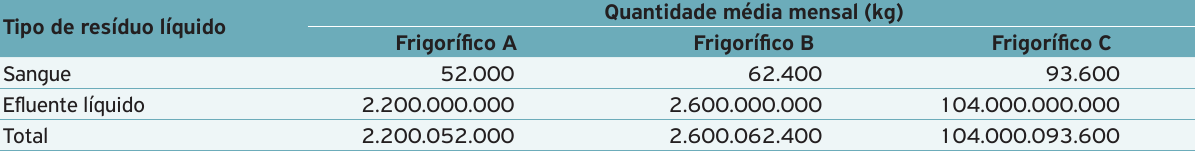
Tabela 2. Tipo e quantidade de resíduos líquidos gerados em frigoríficos que abatem bovinos na cidade de São Luís, Maranhão,